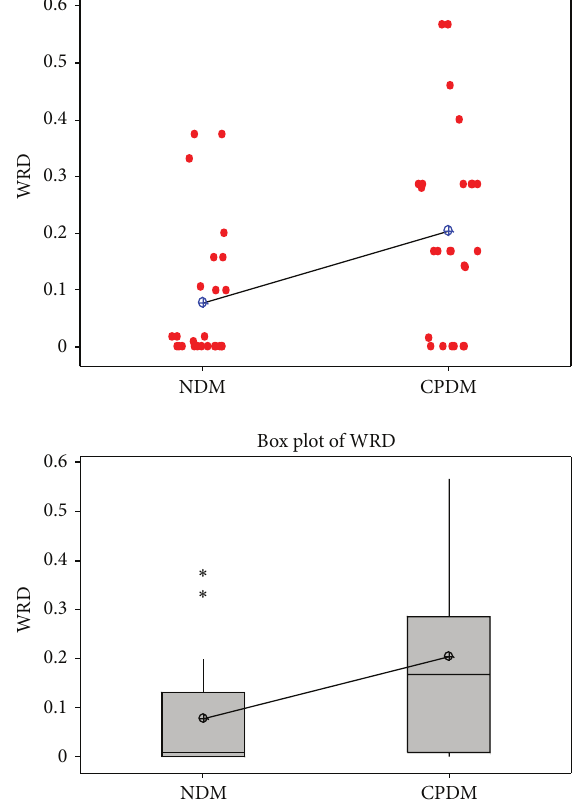
Figure 6: Mean plot and LSD intervals for the NDM and